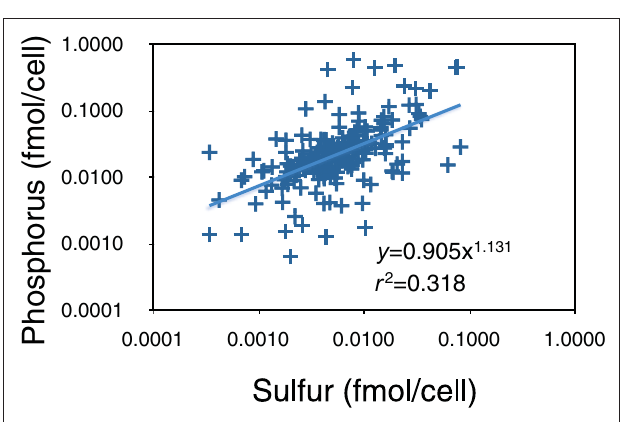
Figure 5 | X-ray microanalysis of P and S-content of bacteria in Lake Myravatnet, Norway. Data are provided as femtomoles per